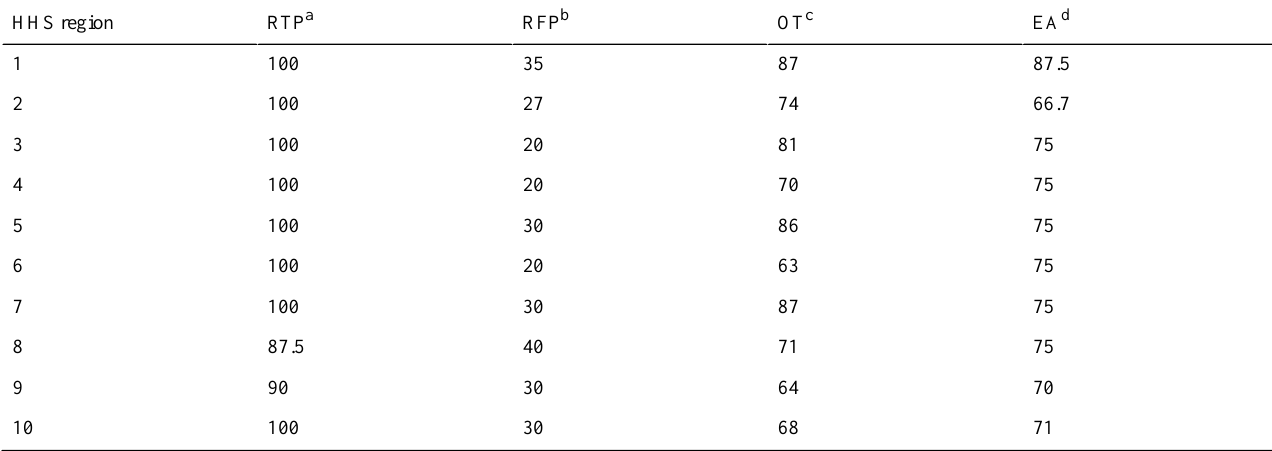
Table 4. Result of negative binomial cumulative sum (threshold = 1 * k) for all performance metrics across all Department of Health and Human Services (HHS) regions of the United